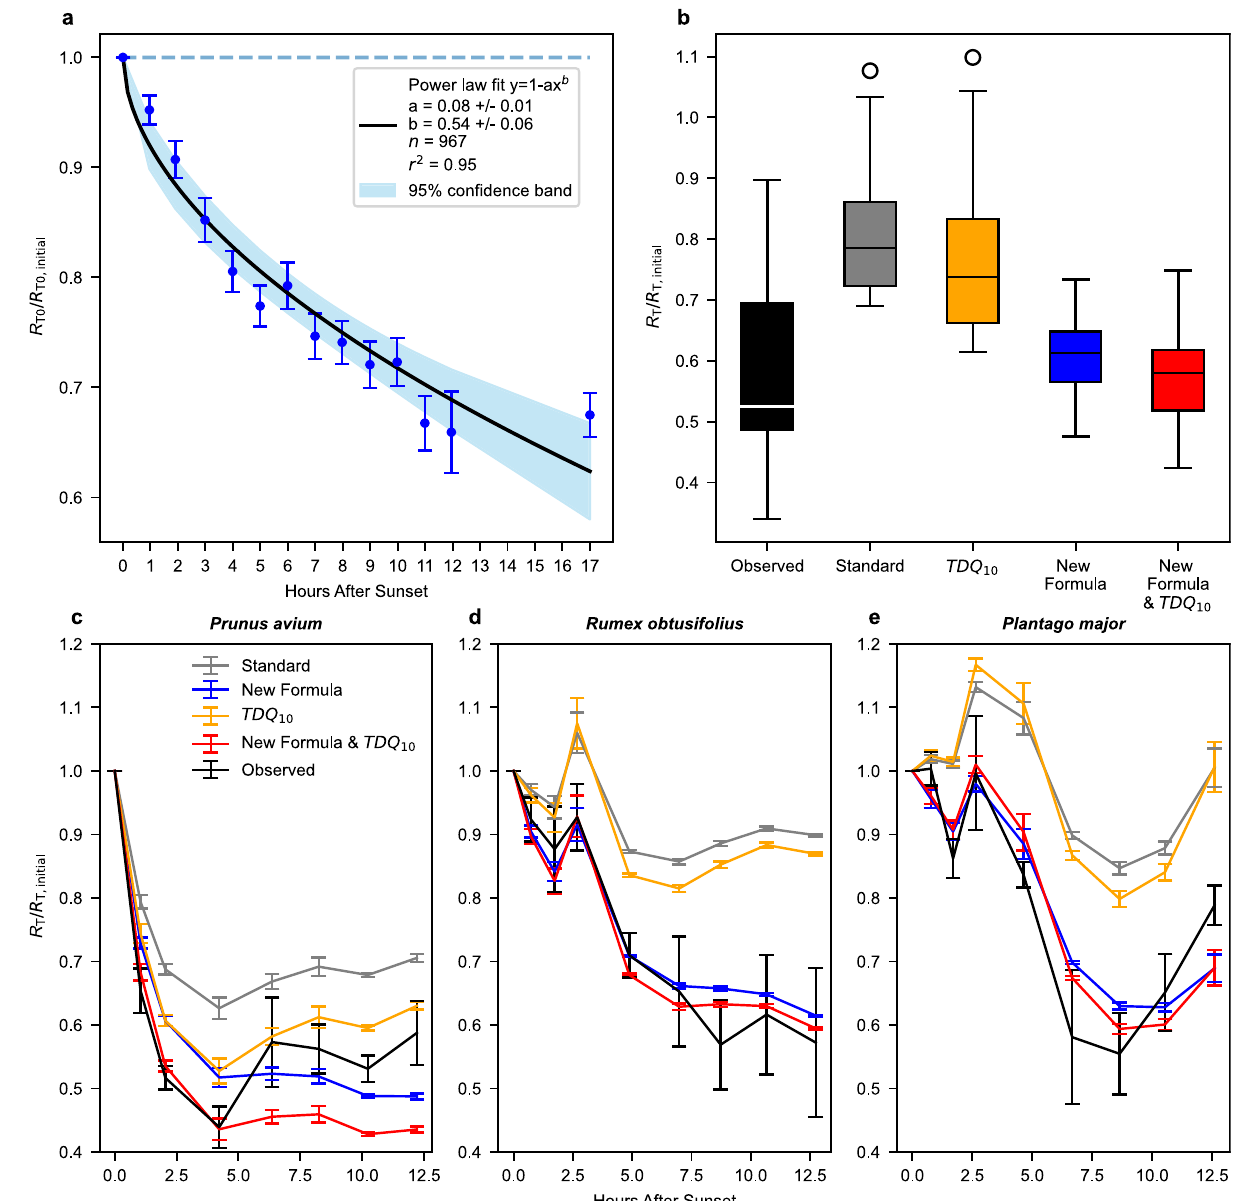
Fig. 1 | Nocturnal variation in the rate of respiration. a Average power function (full line+con fi dence interval in blue, R To / R To-initial =1 – 0.08×h 0.54 , r 2 =0.95) of decrease in nocturnal leaf R To / R To-initial (Supplementary Table 1, 5) measured at constant T o under fi eld (16 species) and lab (15 species) conditions. Each point in the plot represents a mean value of 4 – 92 replicate individuals per hour, across all species (±SEM). n =total of 967 nights of leaf R To / R To-initial across 31 plant species. Null-hypothesisof R To / R To-initial =1(asinEquation1)isshownbyadashedline. R To is leafrespirationataconstanttemperature,T o .Initialde fi nesthe fi